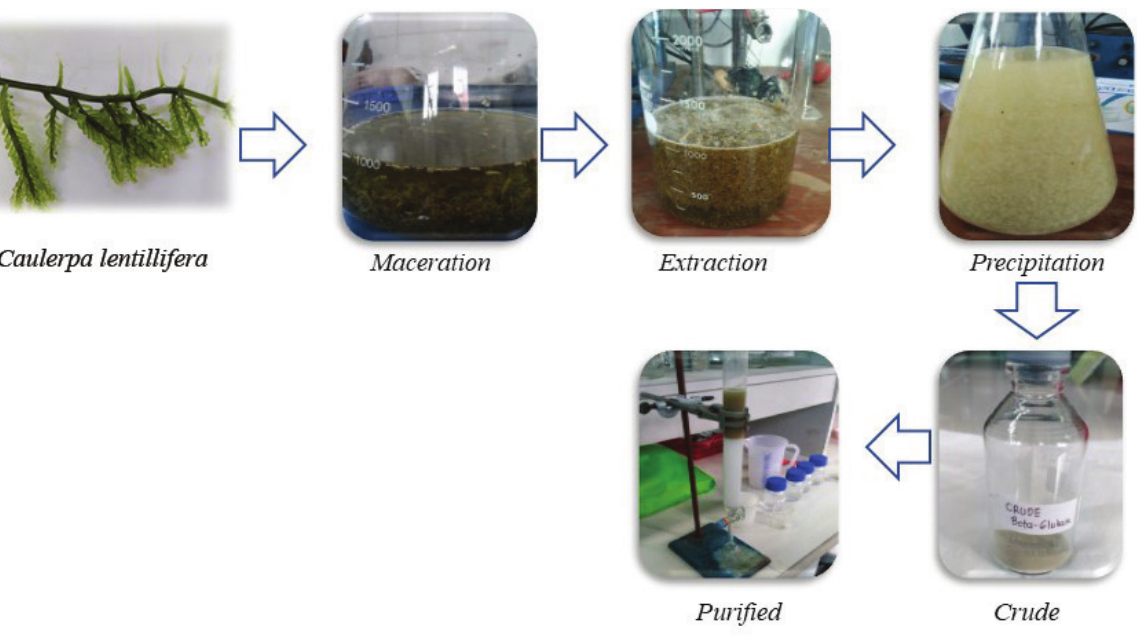
Figure 1. Flow chart of sulfated polysaccharide extraction from C. lentillifera